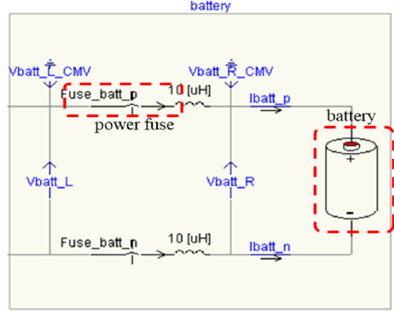
Figure 9. Battery section.